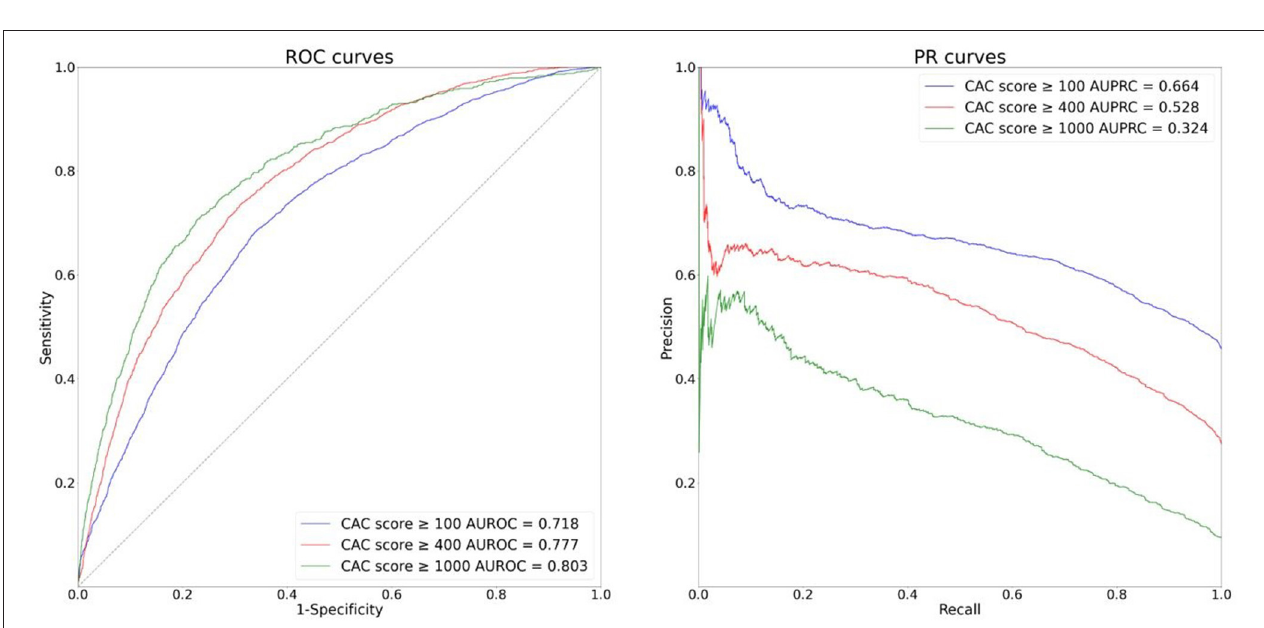
FIGURE 4 | ROC and PR curves of the external validation (YSH